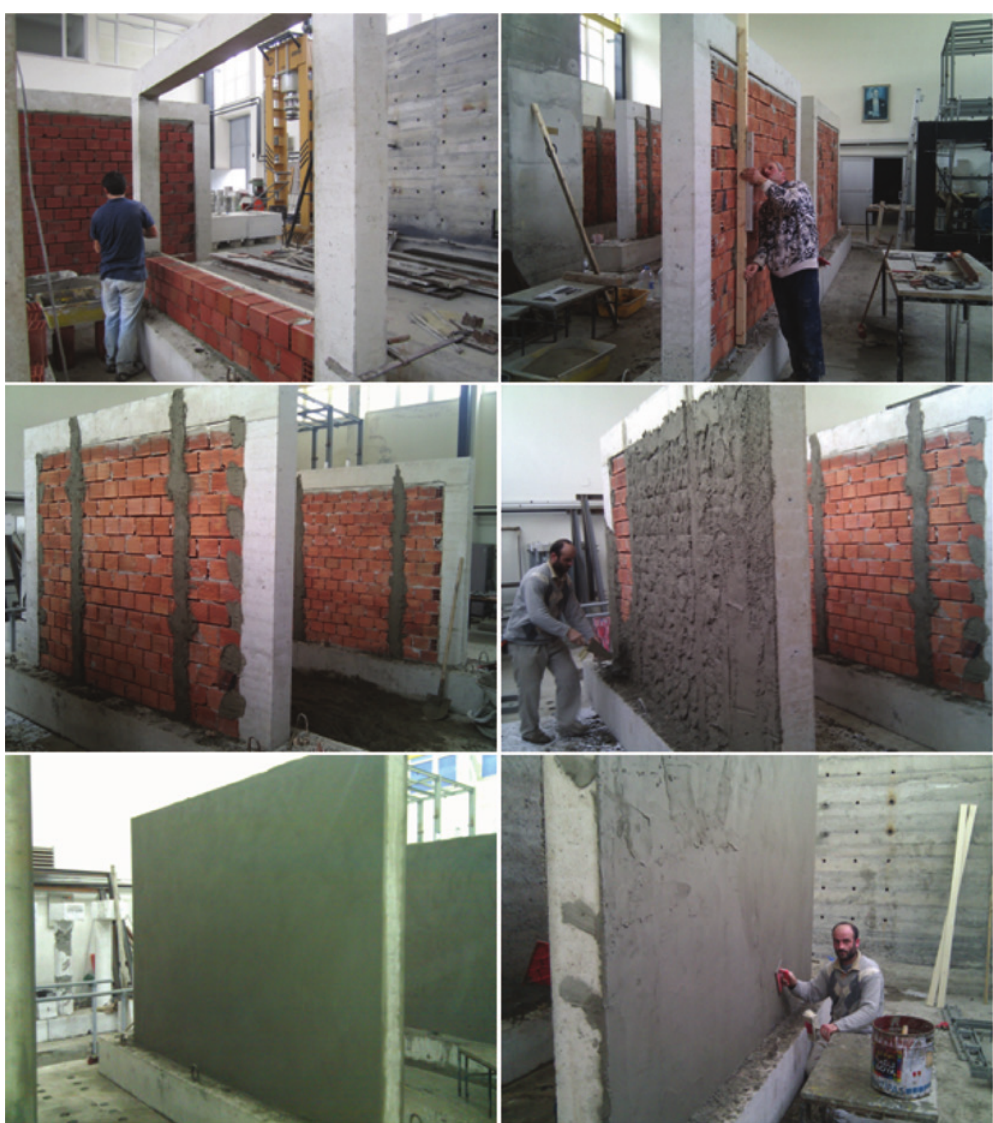
Figure 2: Application of infill wall and concrete plaster.